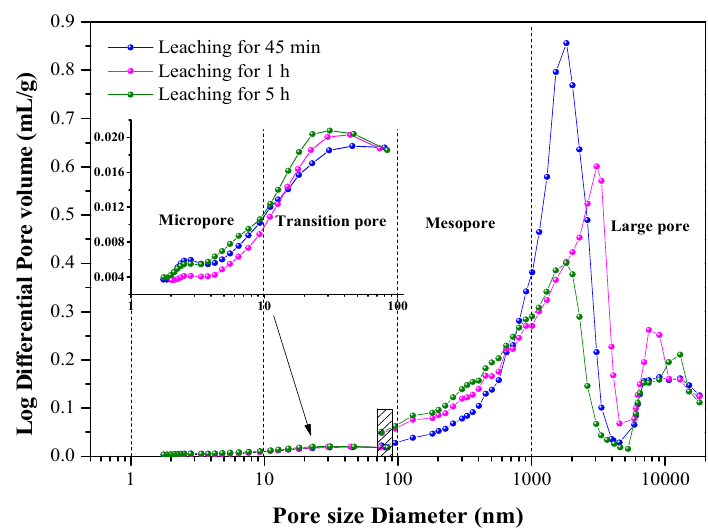
Figure 12. Pore size distribution in the KLR obtained from leaching for different time points with 4 mol/L H 2 SO 4 and 7 wt% K 2 SO 4 at 150 °C. Table 4. Pore characteristics of KLR based on the data of Figure